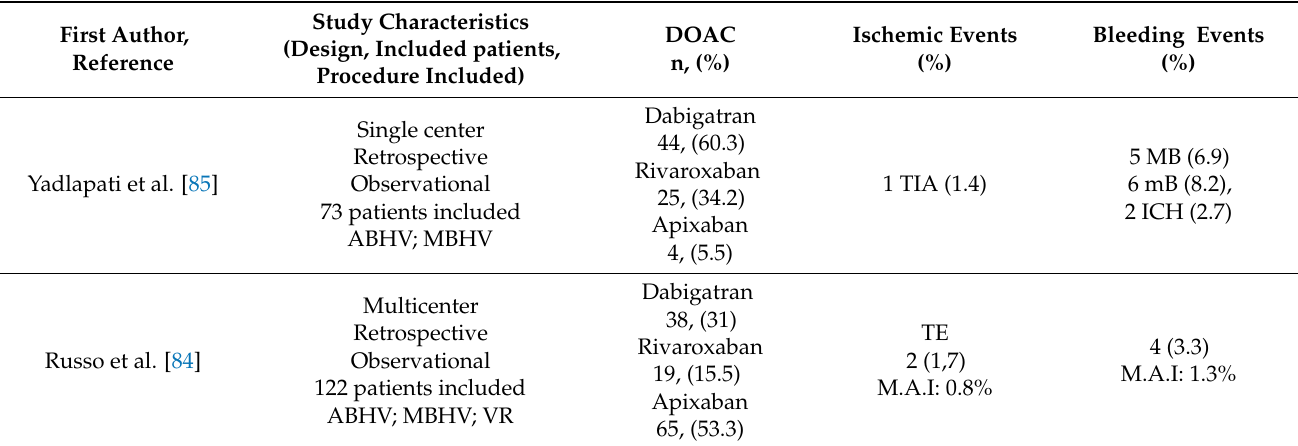
Table 4. Observational studies on the clinical performance of Direct oral anticoagulants after biopros- thetic heart valve replacement in atrial fibrillation